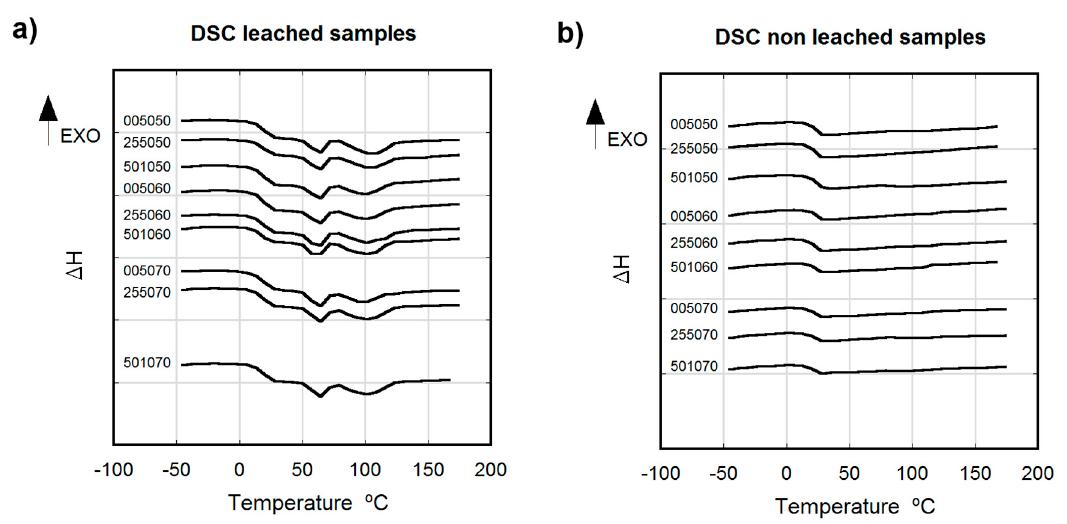
Figure 5. Thermograms of leached ( a ) and non-leached ( b ) aged samples (12 weeks at RT) produced using different porogenerator proportions and particles sizes (exothermic behavior upwards).